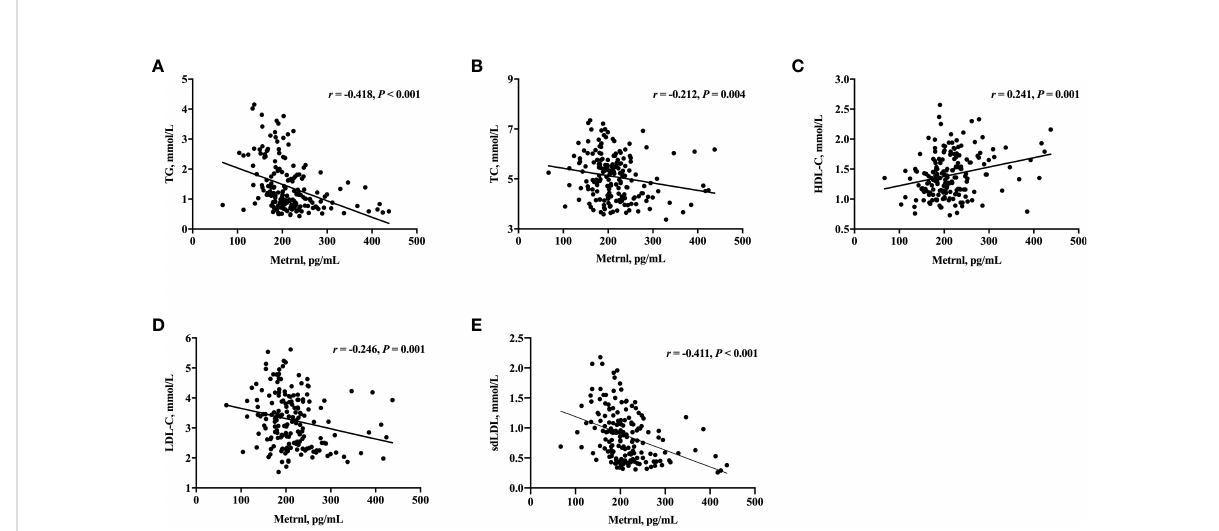
FIGURE 1 Correlation of serum Metrnl levels with TG (A) , TC (B) , HDL-C (C) , LDL-C (D) , and sdLDL (E) in 182 subjects. Spearman ’ s correlation was performed for analysis due to the skewed distribution of Metrnl. P values < 0.05 were considered statistically signi fi